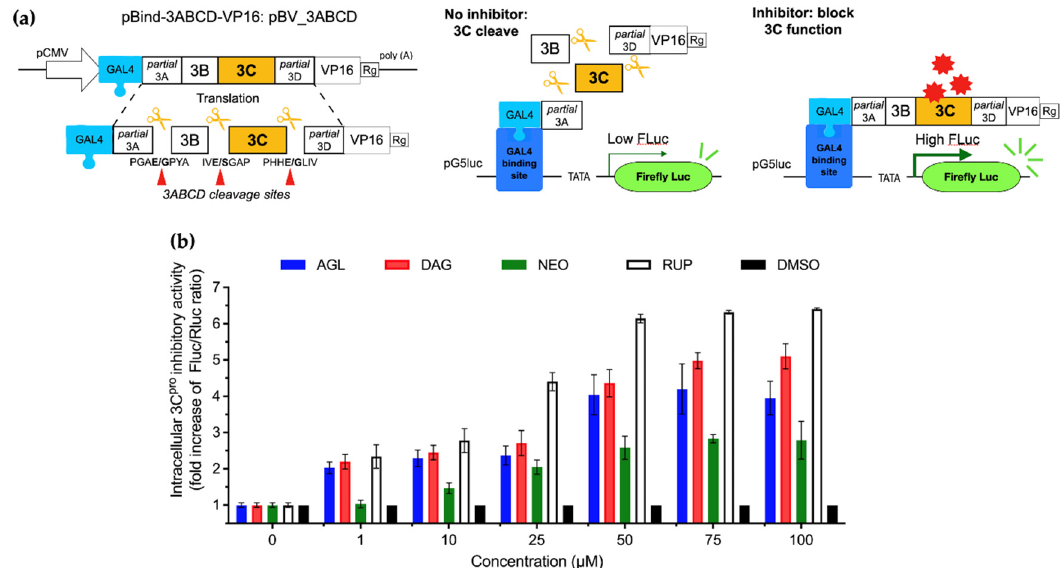
Figure 3. Inhibitory effects of AGL, DAG, and NEO on protease activity of FMDV 3C pro in the intracellular protease assay: ( a ) The schematic diagram of the intracellular protease assay. In this assay, pBV_3ABCD and pG5luc were co-transfected into HEK 293T cells for transient FMDV 3C pro expression. In pBV_3ABCD transfected BHK-21 cells, the active 3C pro cut the polyprotein at the cleavage sites and thus separated VP16 activating domain from Gal4 binding domain. As a result, VP16 was not activated leading to low level of firefly luciferase expression. When andrographolides inhibit protease activity of the 3C pro , the polyprotein is not cleaved. Thus, binding of GAL4-binding domain to GAL4 brought the VP16 activation domain in proximity to the VP16 and drove the firefly luciferase expression; ( b ) The protease activities of FMDV 3C pro were determined based on the signal from the firefly luciferase (FLuc) normalized with that of Rinella luciferase (Rluc) from the pG5luc reporter plasmid. The data were presented as the fold increase in FLuc/Rluc ratios from treatments relative to controls (0.01% DMSO). Rupintrivir served as the 3C pro inhibitor control. The experiments were carried out in triplicates, and the data were present as means and SD.